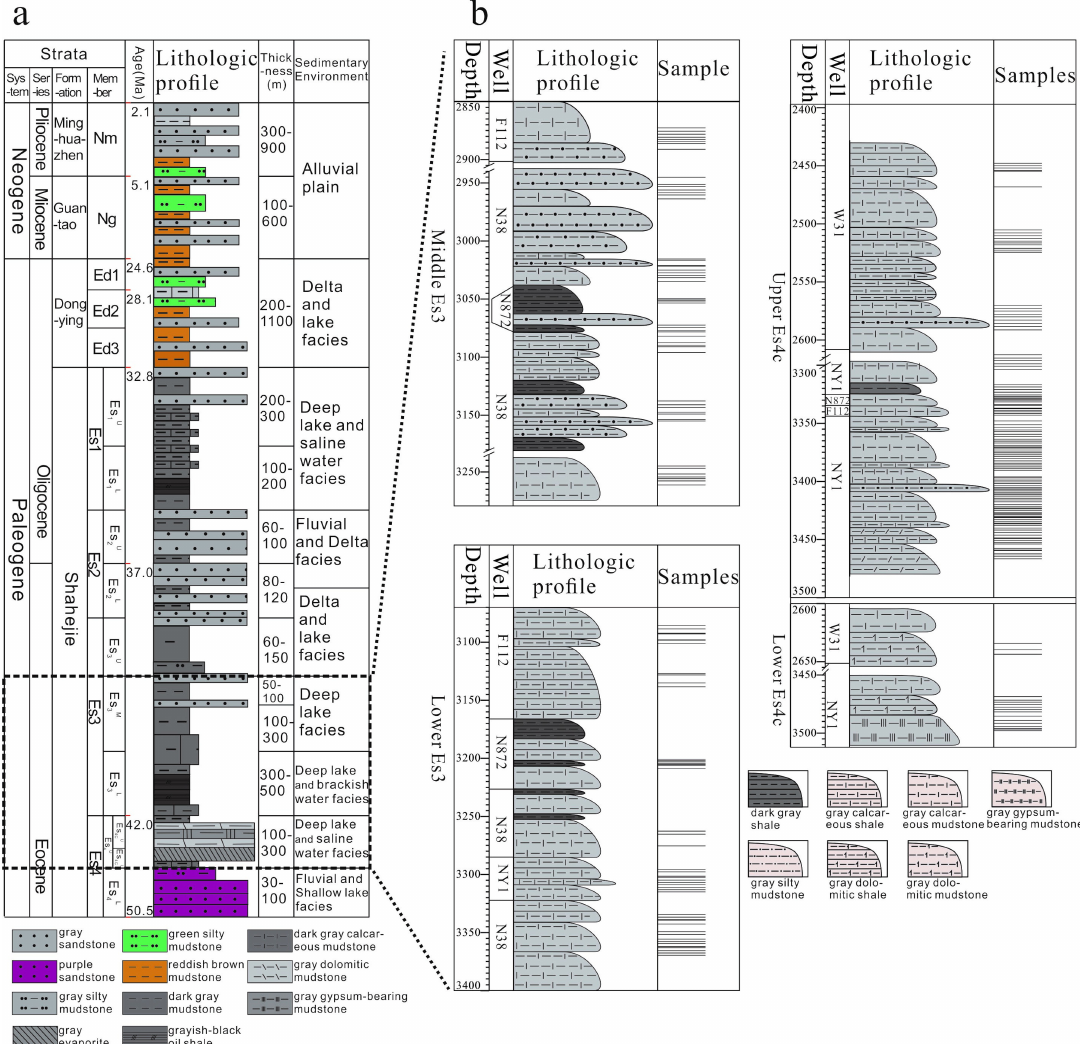
Figure 2. ( a ) Stratigraphic column and sequence stratigraphic framework of the Jiyang Depression (modified after He (2017) [15]). ( b ) Stratigraphic column of the Es 3M , Es 3L , and Es 4U sub-members and the distribution of the